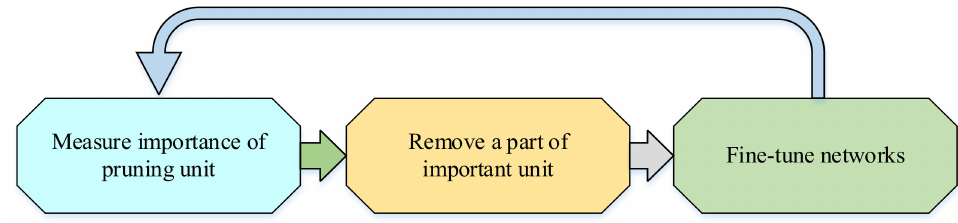
Figure 5. Pruning flow chart.